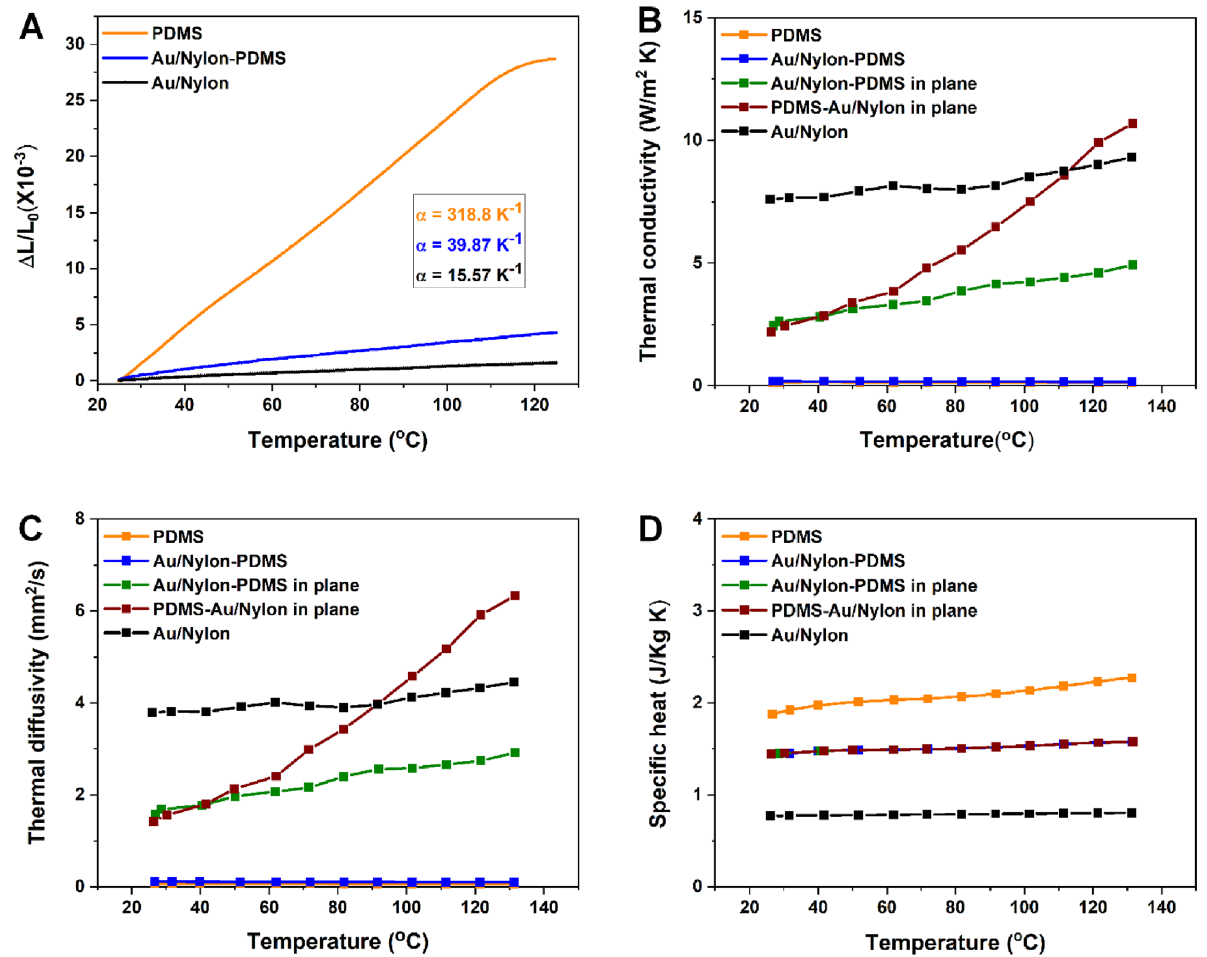
Figure 3. Thermophysical properties of the prepared materials. ( A ) thermal expansion of PDMS, Au/Nylon- PDMS and Au/Nylon measured in plane; ( B ) thermal conductivity versus temperature; ( C ) thermal diffusivity versus temperature; ( D ) specific heat versus